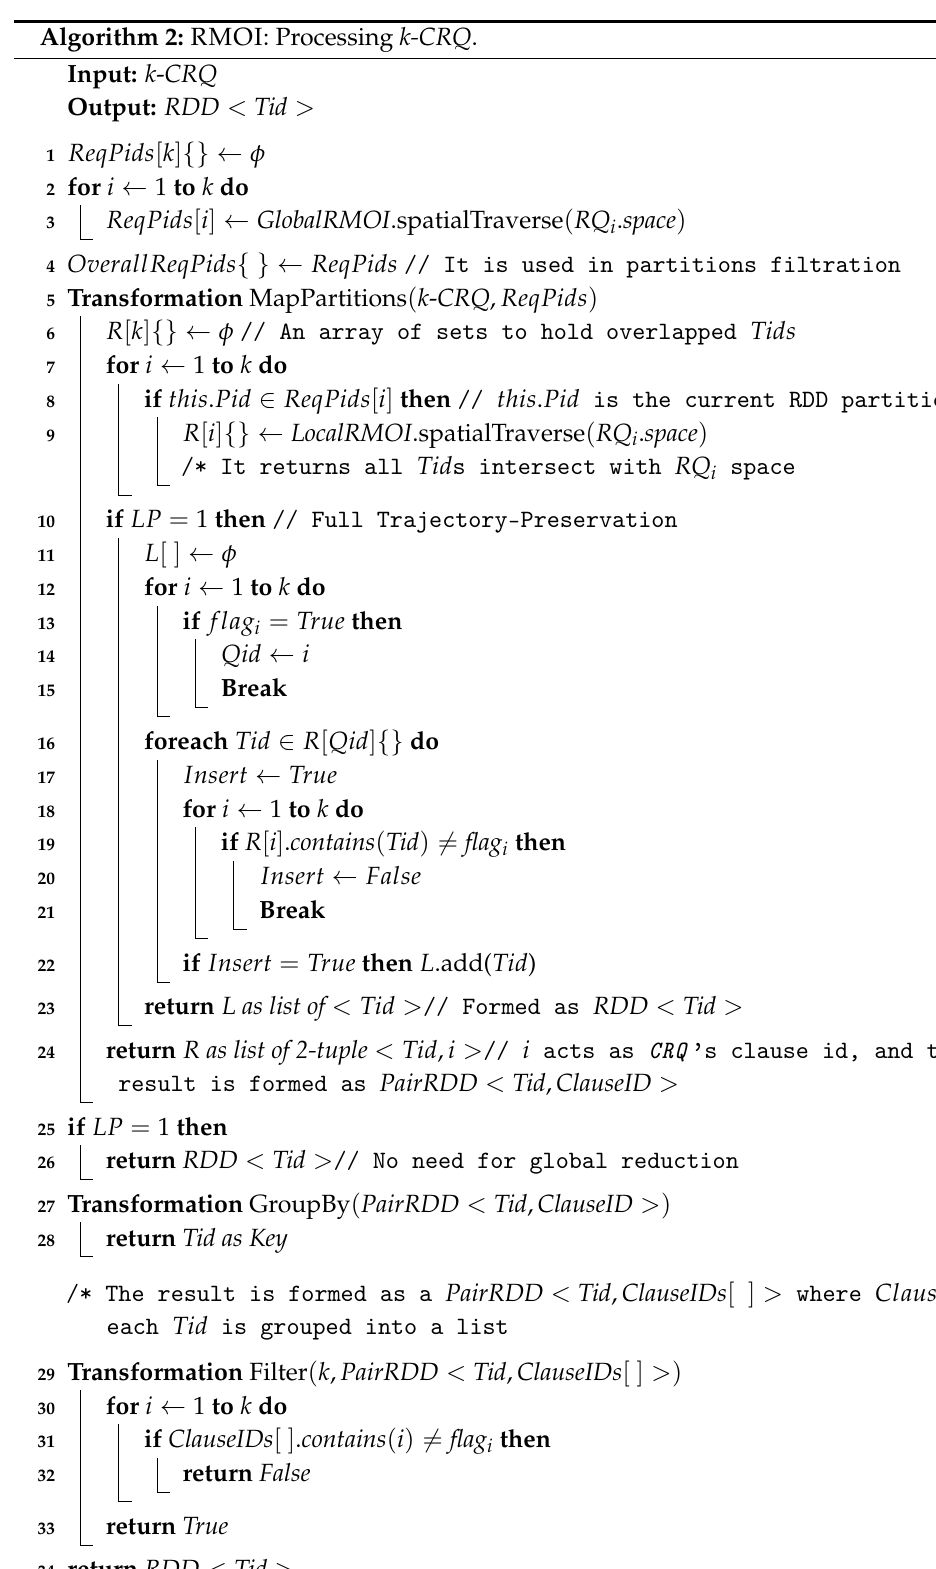
Algorithm 2: RMOI: Processing k-CRQ